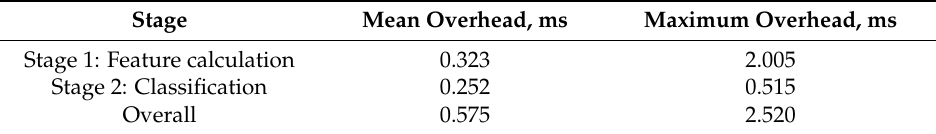
Table 13. Computational overhead of the brake-assisting system.